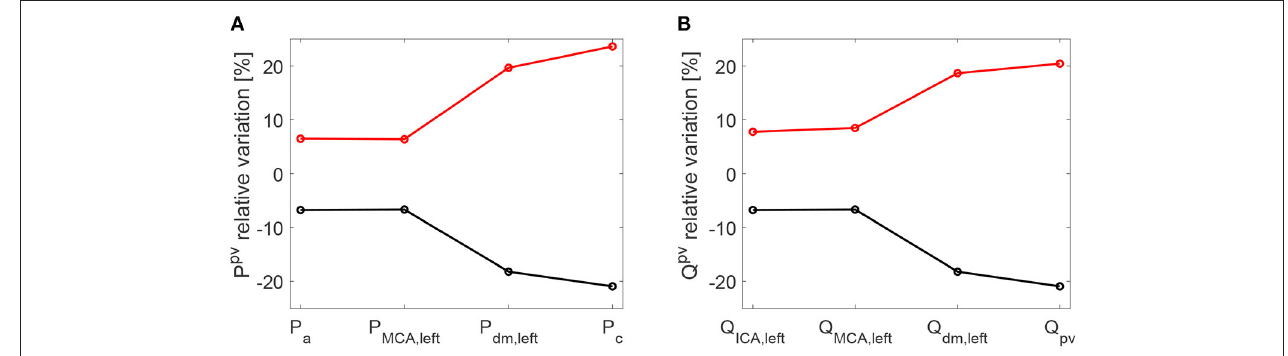
FIGURE 8 | Relative variations [%] of pulse values per beat with respect to baseline: pressure ( P pv − P pv baseline ) / P pv baseline · 100 (A) and flow rate ( Q pv − Q pv baseline ) / Q pv baseline · 100 (B) . Pulse values, P pv and Q pv , are evaluated at each site of the ICA-MCA pathway. Black: decreased HRV/baseline. Red: increased HRV/baseline.